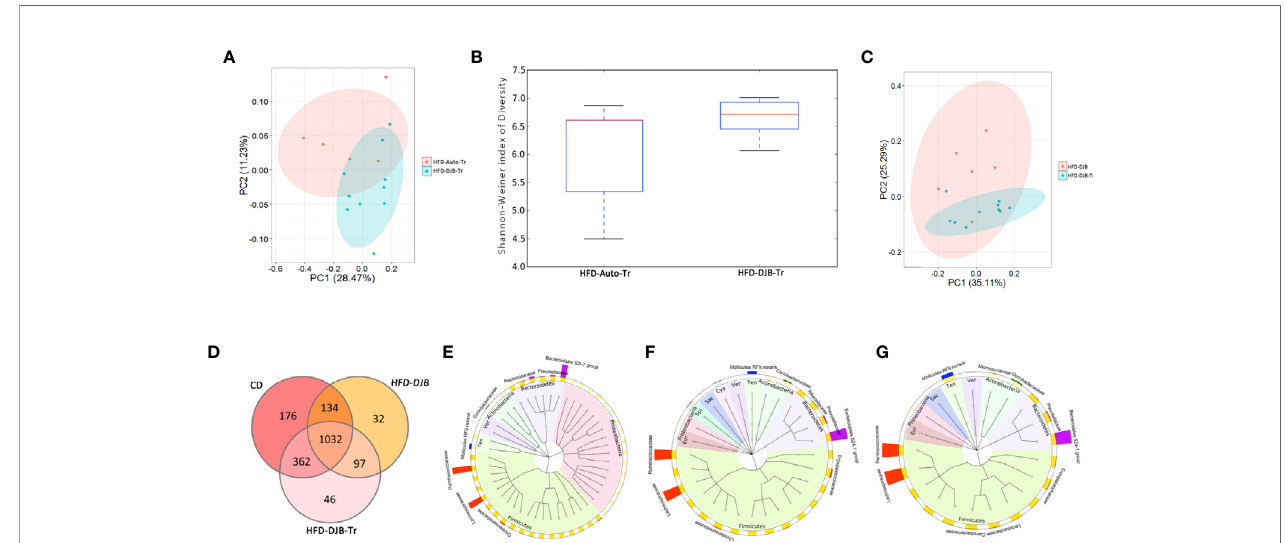
FIGURE 5 | Microbiota associated with improvement of hepatic steatosis in DJB-operated rats. (A) PCoA plot showing the unweighted UniFrac distance between HFD-DJB-Tr and HFD-Auto-Tr rats. Each rat is identi fi ed by a point. (B) Shannon-Weiner index representing the alpha-diversity in HFD-DJB-Tr and HFD-Auto-Tr rats. (C) PCoA plot showing the weighted UniFrac distance between HFD-DJB-Tr and HFD-DJB rats. Each rat is identi fi ed by a point. (D) Venn diagram based on OTU distribution between CD-fed, HFD-DJB and HFD-DJB-Tr rats. (E) The GraPhlAn (Graphical Phylogenetic Analysis) visualization of the OTUs that were not signi fi cantly different among CD-fed, DJB and DJB-Tr rats (P>0.05, Kruskall Wallis test). (F) TheGraPhlAn visualization of the OTUs that were signi fi cantly decreased in HFD-fed rats as compared with CD-fed rats (P<0.05, Wilcoxn rank sum test). (G) The GraPhlAn visualization of the overlapping OTUs between (E, F) The GraPhlAn visualizations were constructed based on the phylogenetic tree of the microbes in the samples. The ring around the phylogenetic tree is the heatmap of the microbial community. The heatmap is based on the phylum level. The intensity of the color in the heatmap represents the relative abundance of the identi fi ed phyla. The outer ring around the heatmap is the barplot of the microbial community based on the family level. HFD-Auto-Tr, n=5; HFD-DJB-Tr, n=10. DJB, Duodenal-jejunal bypass surgery; HFD, High fat diet; OTU, operational taxonomic unit; Cya, cyanobacteria; Eur, Euryarchaeota; Sac, saccharibacteria; Spi, spirochaetae; Ten, Tenericutes; Ver,